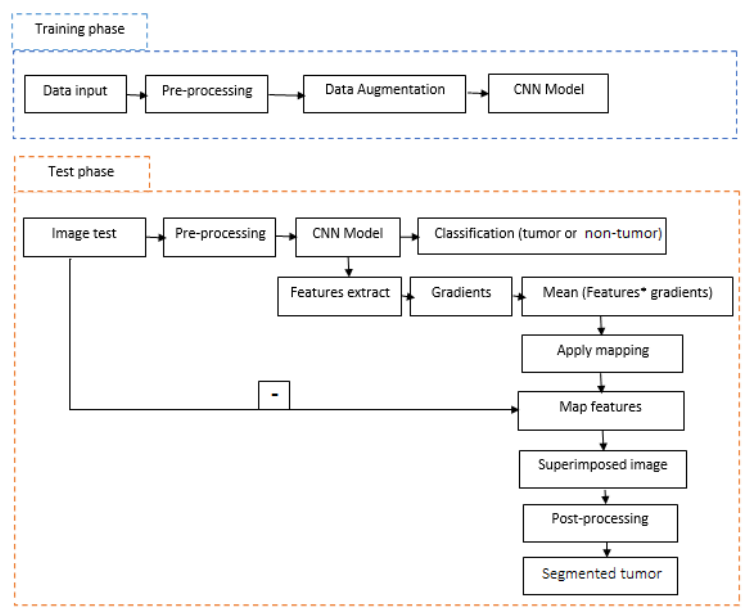
Figure 1. General architecture of the proposed method.